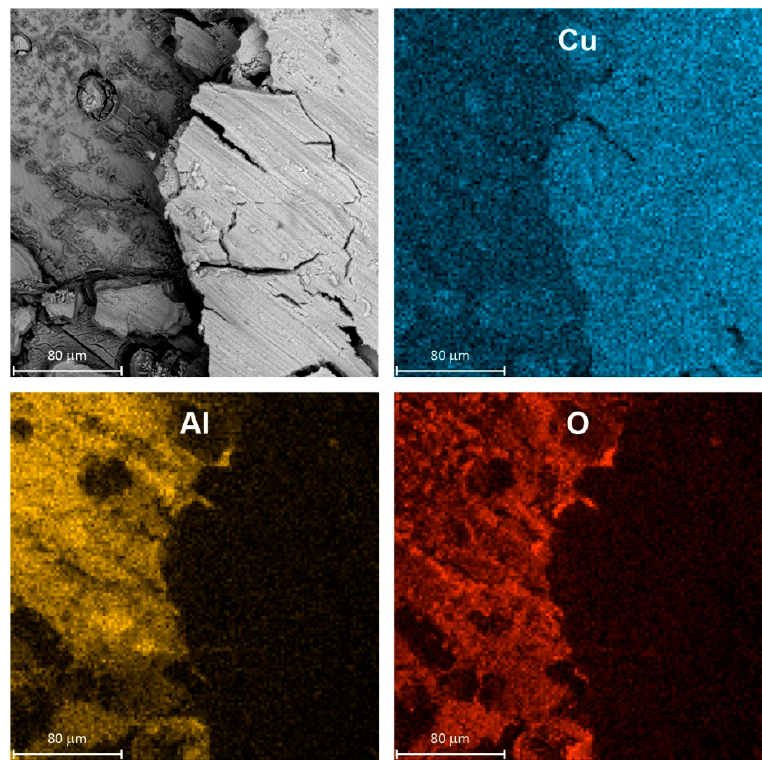
Figure 4. Micrograph of intermetallic Al 2 Cu after corrosion in H 2 SO 4 solution without Na 3 VO 4 , pH = 1.3, immersion time t = 576 min, T = 303 K together with spatial distribution of elements, color intensity differences on EDX maps occur due to different concentration of elements and are also related to height of the specimen.